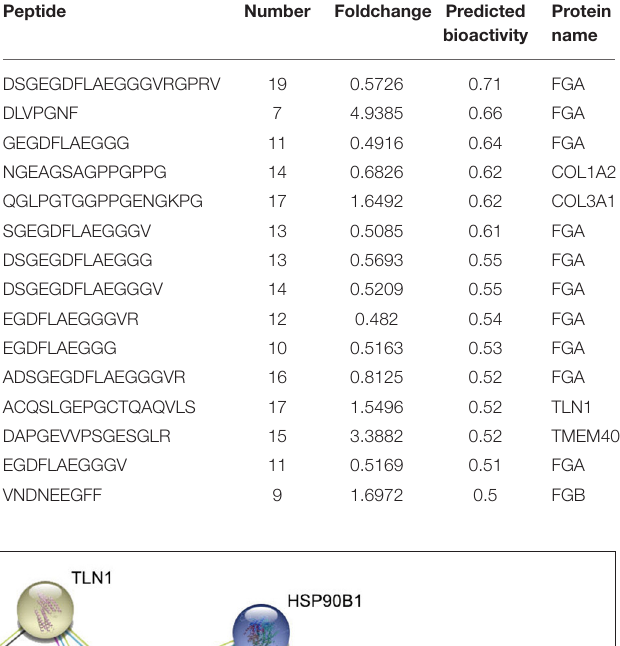
TABLE 3 | Predicted the bioactivity of the part differentially excreted peptides by peptideranker (bioactivity > 0.50).